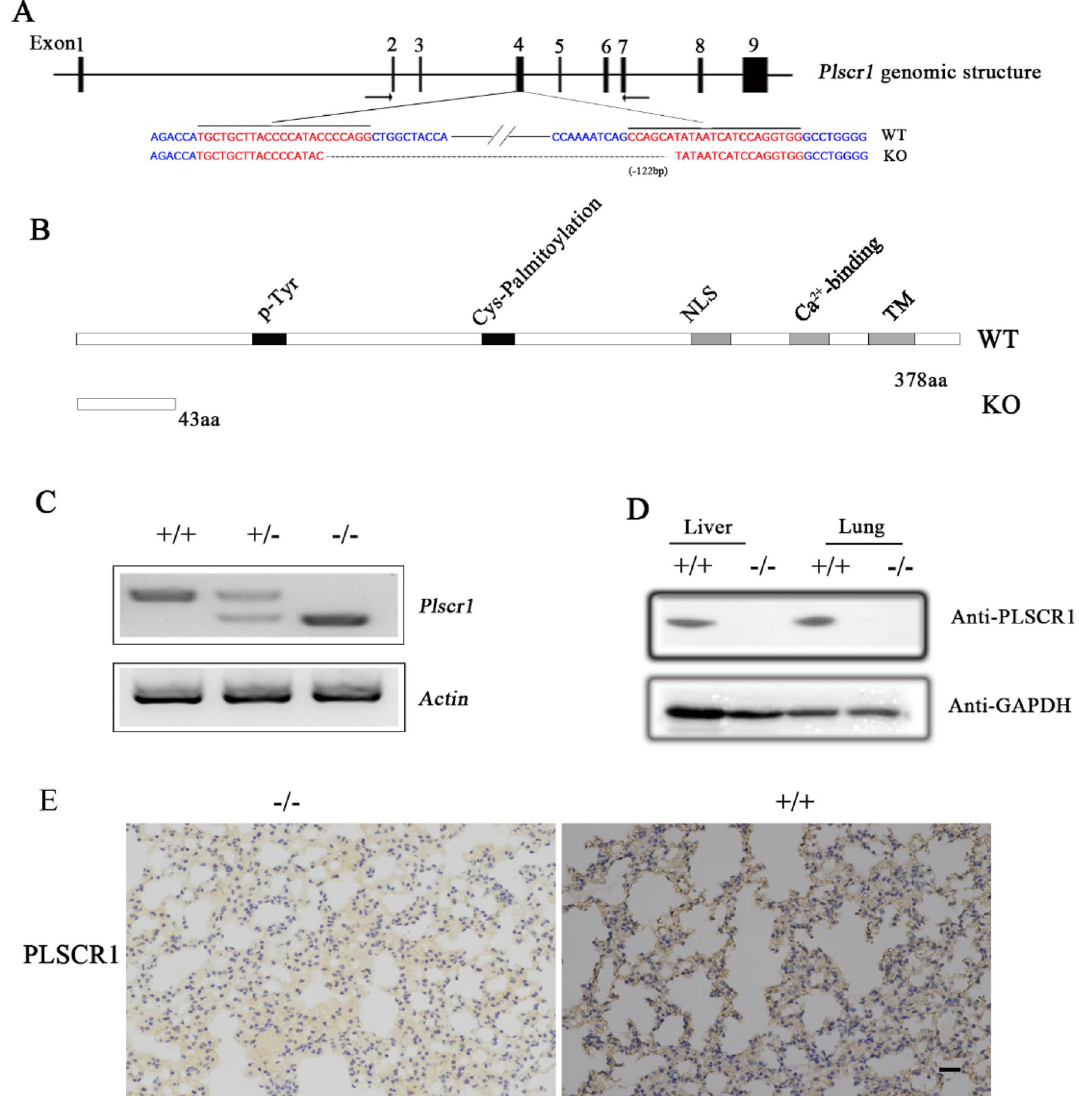
Figure 2. Construction of Plscr1 knockout mice. ( A ) The schematic drawing of the strategy for Plscr1 gene disruption. The target sites of clustered regularly interspaced short palindromic repeat (CRISPR)-Cas9 small guide RNAs (sgRNAs) in the Plscr1 gene are indicated in red, and the deleted region in the Plscr1 gene of knockout mice is indicated by dashes. The positions of RT-PCR primers are indicated by arrows. ( B ) The schematic drawing of the domain structure of PLSCR1 in wildtype and knockout mice. ( C ) The expression of Plscr1 mRNA in the tail of P42 mice was determined by RT-PCR. β-actin was included as the internal control. The corresponding size were respectively 636 bp, 514 bp corresponding to wild types and Plscr1 -/- mice. ( D ) Western blot showed the expression in the liver and lung of P42 mice. ( E ) PLSCR1 was detected by immunohistology using rabbit anti-mPLSCR1, visualized with 3,3,-diaminobenzidine, and counterstained with hematoxylin. Scale bar: 20 μm. +/+ :wild type mice; +/− : heterozygous mice; −/−: Plscr1 knockout gradually returns to the normal level by 14 dpi (Fig. 1D and E). This dynamic change of PLSCR1 expression suggests that PLSCR1 might play an essential role in SIV infection in vivo. H1N1 SIV replication is increased in Plscr1 knockout mice. In order to investigate the functions of PLSCR1 during Influenza A virus infection in vivo, we developed Plscr1 knockout mice using CRISPR/Cas9 genome editing technique. The mouse Plscr1 gene contains eight exons encoding 378 amino acids, and two sgR- NAs were designed to target exon 4 (Fig. 2A). DNA sequencing revealed that a deletion of 122 bp was introduced into exon 4 in Plscr1 knockout mice, which causes a premature translational stop and gives rise to a potentially truncated protein of 43 amino acids (Fig. 2B). RT-PCR, western blot, and immunohistochemistry results con- firm that PLSCR1 expression is indeed disrupted in the homogenous knockout mice (Fig. 2C–E). Interbreeding of Plscr1 +/− mice gave rise to offspring in the expected Mendelian ratio (23.8% wild-type, 47.6% Plscr1 +/− , and